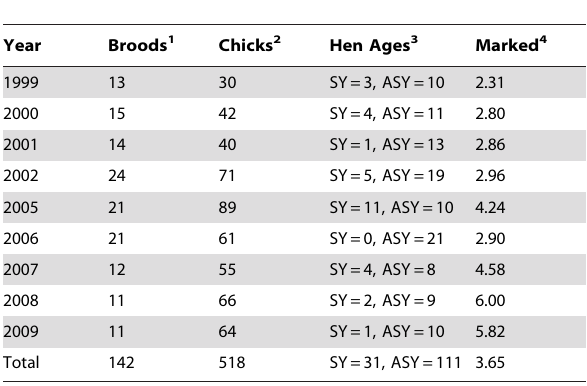
Table 1. Capture statistics for greater sage-grouse chicks marked in Idaho (1999–2002) and Utah